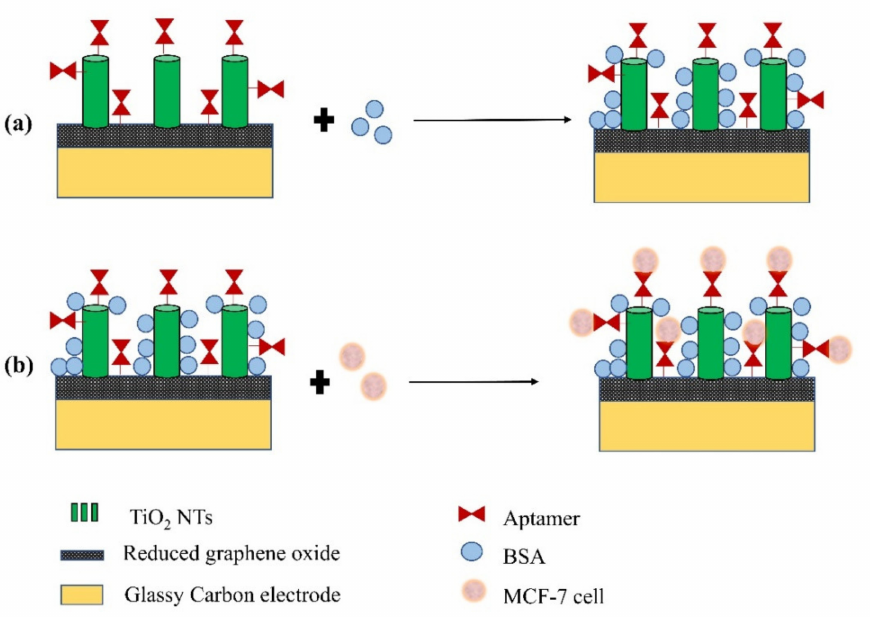
Figure 13. Schematic representation of the preparation of the functionalized WE for the detection of MCF-7 cells. Initially, a blockade of non-specific sites of WE is performed with BSA ( a ), and then WE are treated with the cells for detection ( b